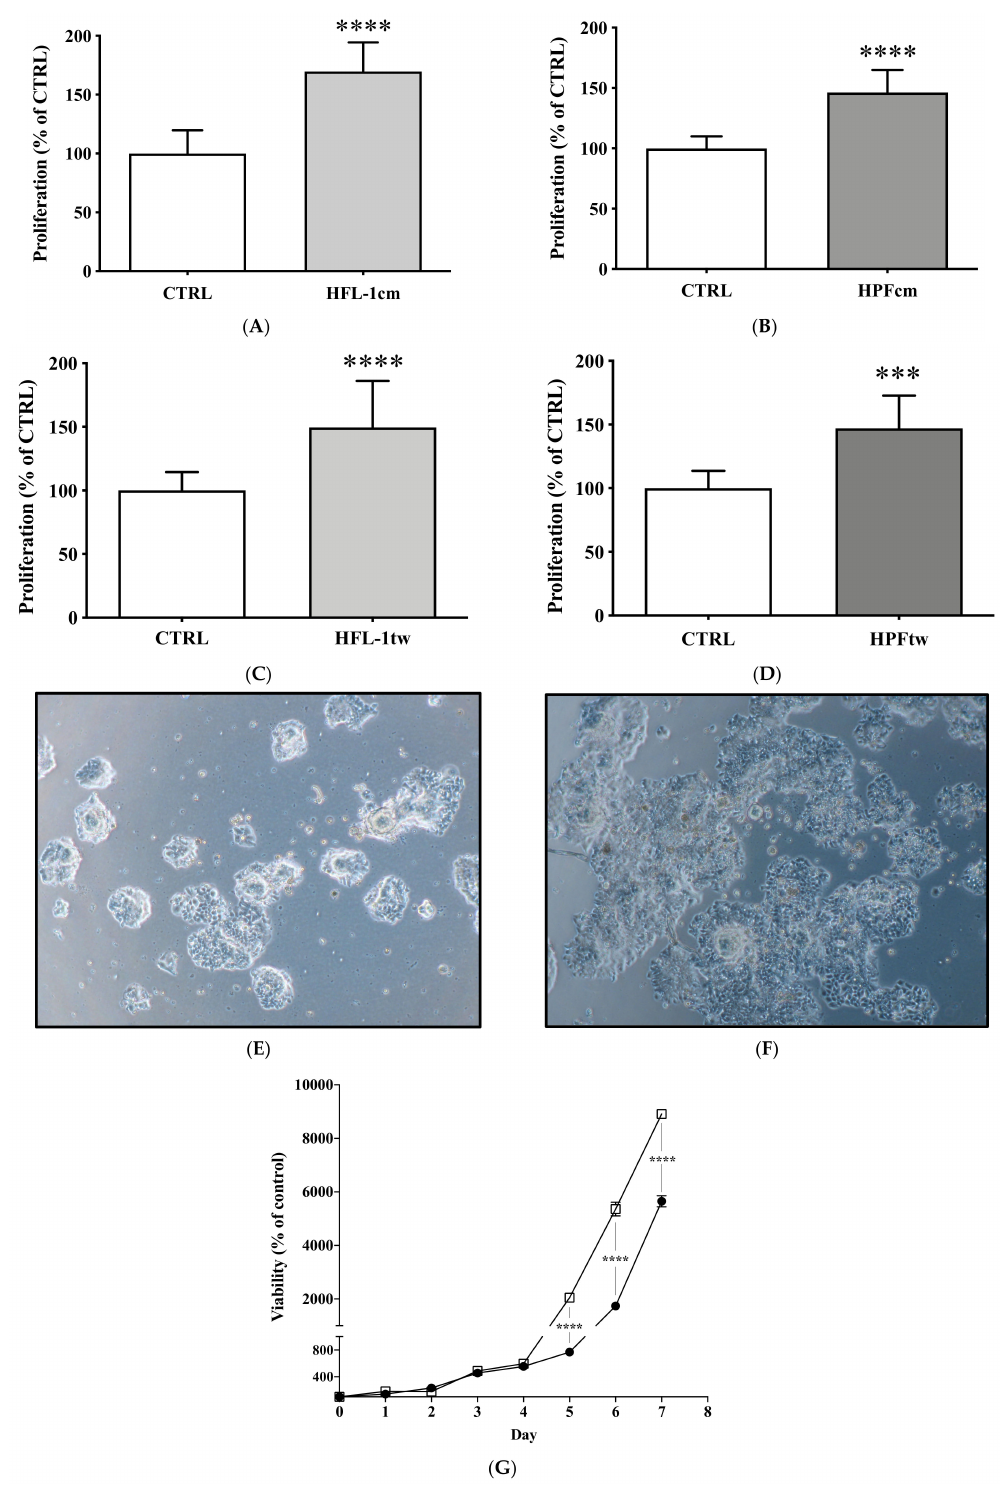
Figure 2. Impact of human fibroblasts on the proliferation of BON-1 cells. ( A ) Increase in the proliferation of BON-1 when incubated with HFL-1cm ( A ) or HPFcm ( B ) compared to the controls. The proliferation of BON-1 cells also increased significantly in the presence of either HFL-1 cells (HFL-1tw ( C )) or HPF cells (HPFtw ( D )) in the corresponding transwell experiments. ( E ) Picture taken of BON-1 in control situation. Note the increased density of the cell layer when BON-1 was incubated with the HPFcm ( F ). ( G ) Cellular viability of BON-1 cells in the presence ( (cid:3) ) of HPFcm as compared to control ( • ) over a 7 day period. **** p < 0.0001; *** p <